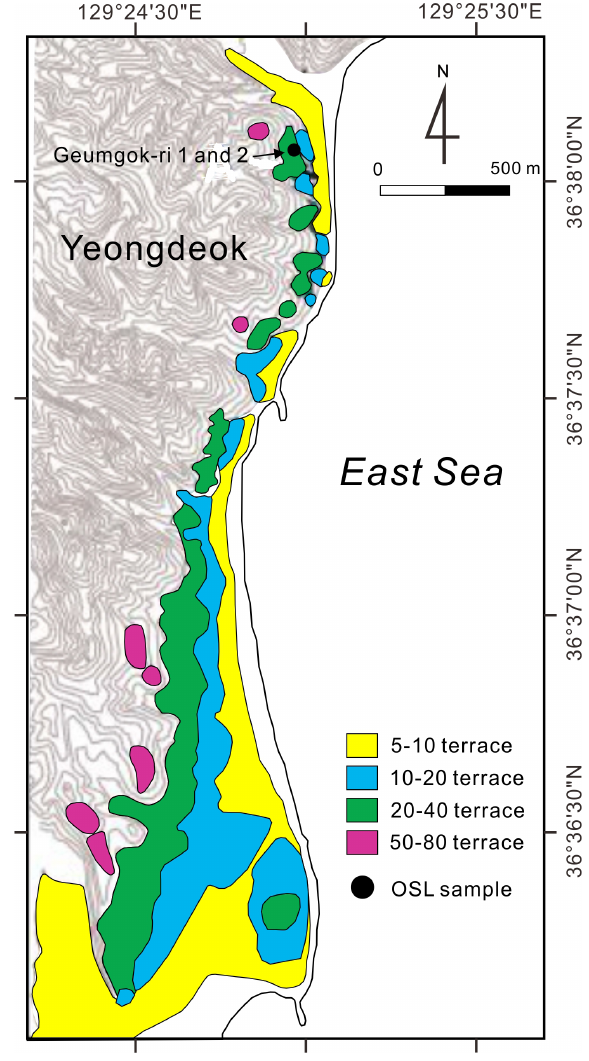
Figure 3. Marine terraces at subsite Geumgok-ri of the Yeongdeok area in the eastern Korean Peninsula (modified after Hong, 2014). The topographic contour interval is 10m. For location, see Fig. 2.